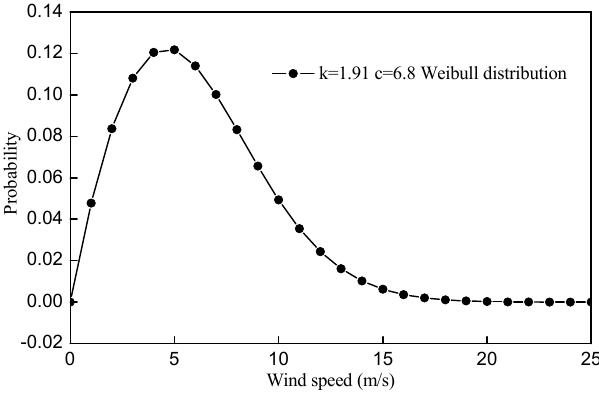
Figure 12. Weibull probability distribution of wind speed.